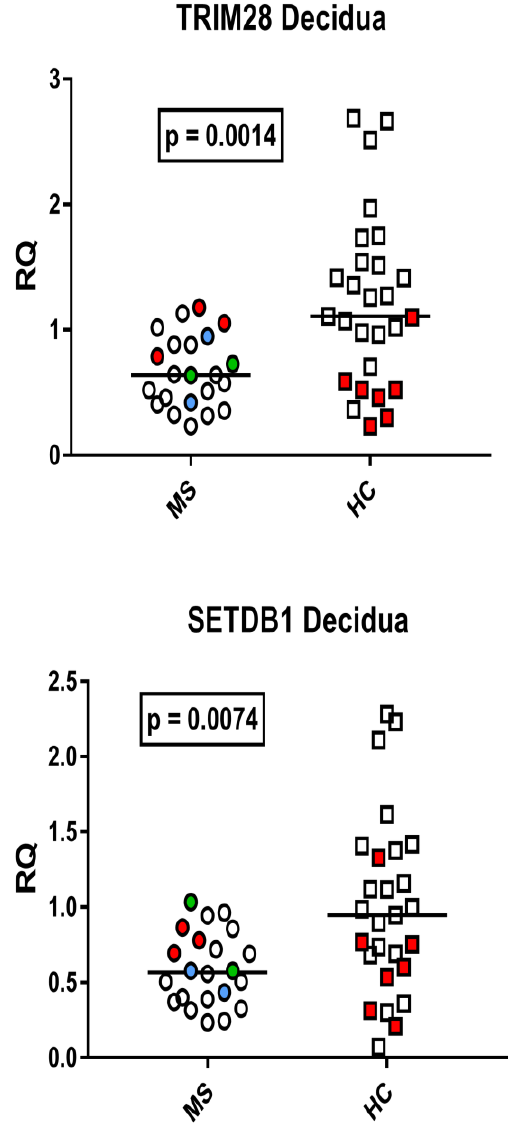
Figure 5. Expression of TRIM28 and SETDB1 in decidua basalis of 22 placentas from 20 mothers with multiple sclerosis (MS) (Group A) and 27 placentas from healthy control (HC) mothers (Group B). RQ: relative quantification. Circles and squares show the mean of three individual measurements; horizontal lines show the median values. Premature deliveries are shown in red; these include two pairs of twins in blue and green. Medians and IQR 25–75%: TRIM28: Group A (mothers with MS) 0.64, IQR 0.43–0.88; Group B (unaffected mothers) 1.11, 0.65–1.53; SETDB1: Group A 0.57, 0.39–0.77; Group 0.95,